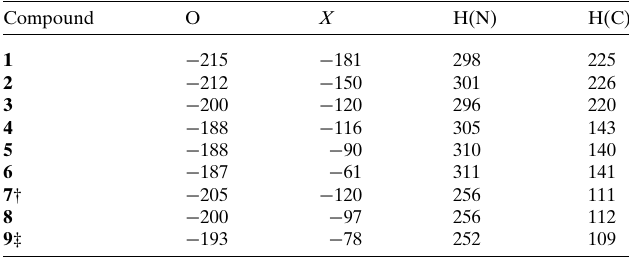
Table 2 Calculated MEP values (in kJ mol (cid:4) 1 ) on the two best hydrogen-bond donor and acceptor sites for compounds 1 – 9 , as indicated in Fig. 12 (blue and red atoms). Compound